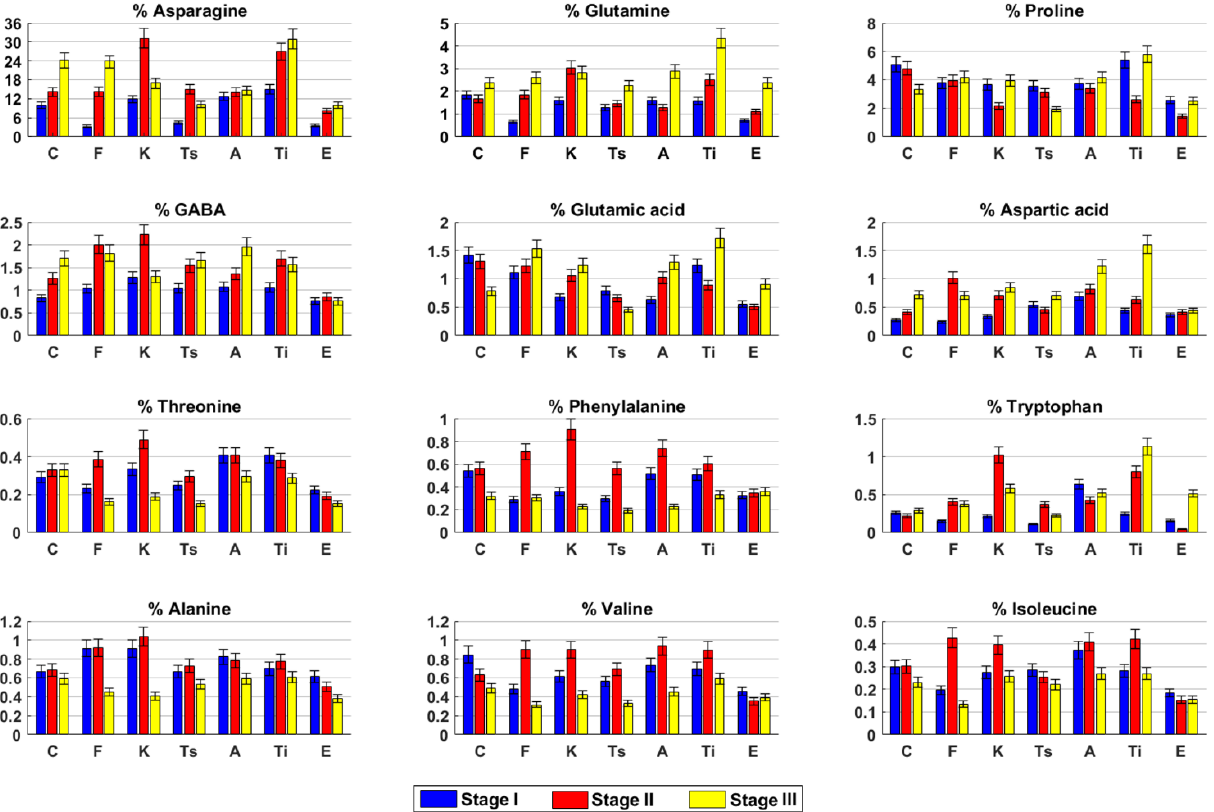
Figure 2. Free amino acids content in hydroalcoholic extracts of Cannabis sativa L. fresh inflorescences at three harvesting stages. C (Carmagnola), F (Fibranova), K (Kompolti), Ts (Tisza), A (Antal), Ti (Tiborszallasi), E (Eletta Campana).